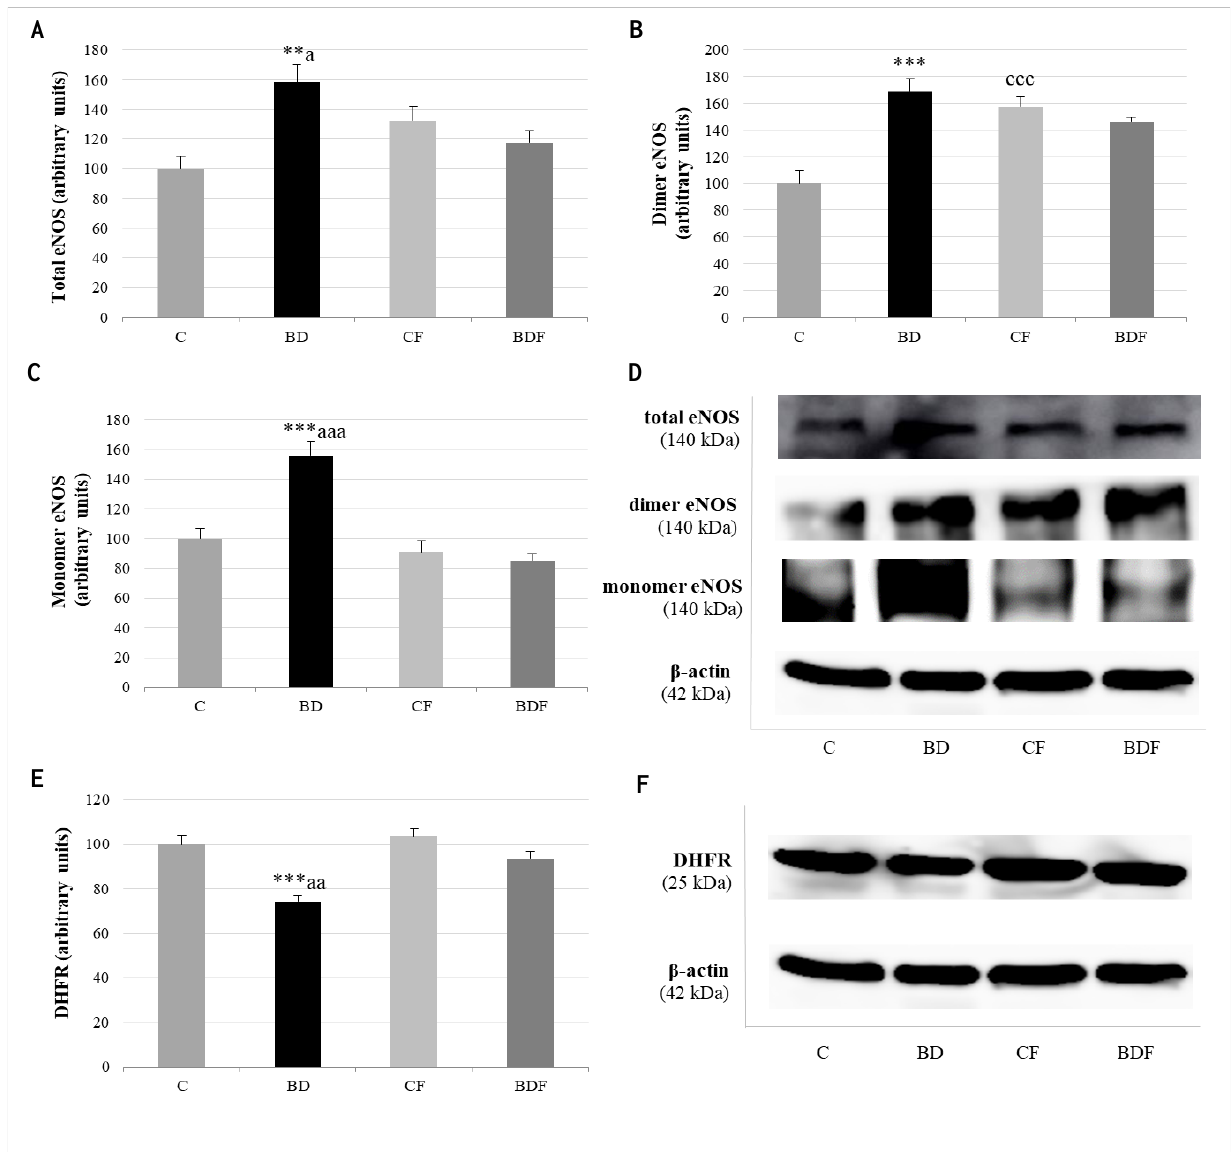
Figure 5. Role of DHFR enzyme in the expression of coupled and uncoupled eNOS in the liver of adolescent rats. Expression of eNOS (expressed as percent arbitrary relative units, referring to values in control animals which were defined as 100%): total eNOS ( A ), dimer-coupled eNOS (producer of NO) ( B ) and monomer-uncoupled eNOS (producer of O 2 •− ) ( C ). Representative Western blot for the expressions of total, dimer and monomer eNOS and β -actin (as load control) ( D ). Expression of DHFR in the liver of adolescent rats (expressed as percent arbitrary relative units, referring to values in control animals which were defined as 100%) ( E ). Representative Western blot for the expressions of DHFR and β -actin (as load control) ( F ). The results are expressed as mean ± SEM and analysed by a multifactorial one-way ANOVA followed by Tukey’s test. The number of animals in each group is 6 and n = 6 for eNOS and DHFR expression determinations. eNOS: endothelial nitric oxide